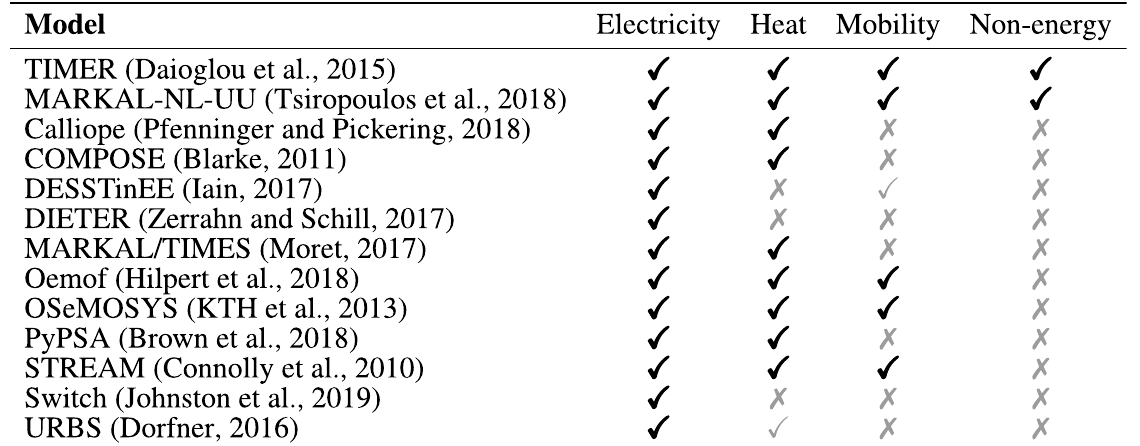
TABLE 1 Comparison of the energy sector accounted for in existing models for the large-scale system design.